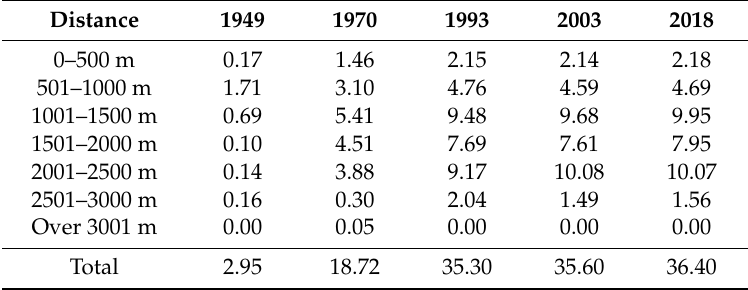
Table 7. The areas of collective housing related to railroad station accessibility (in